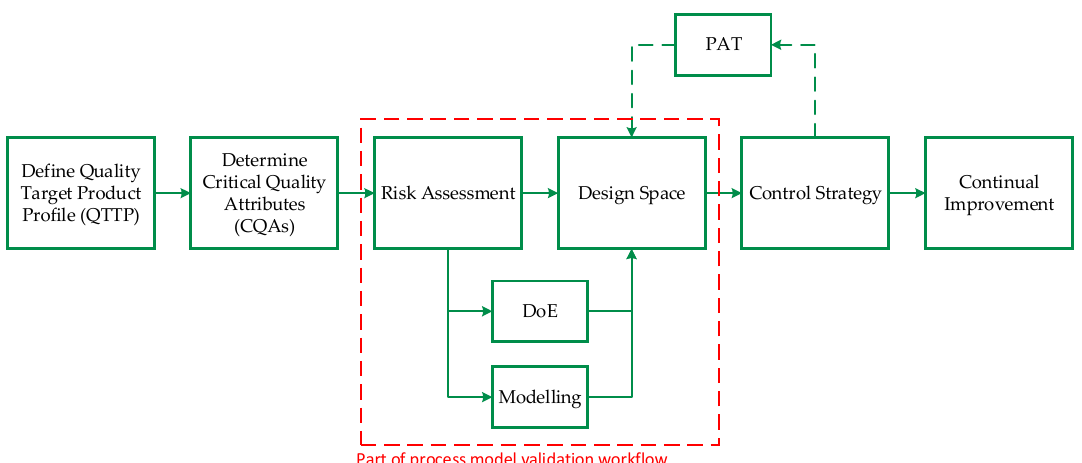
Figure 2. Quality by design (QbD) approach for quality assurance [49,50]. Fish Bone/Ishikawa Diagram